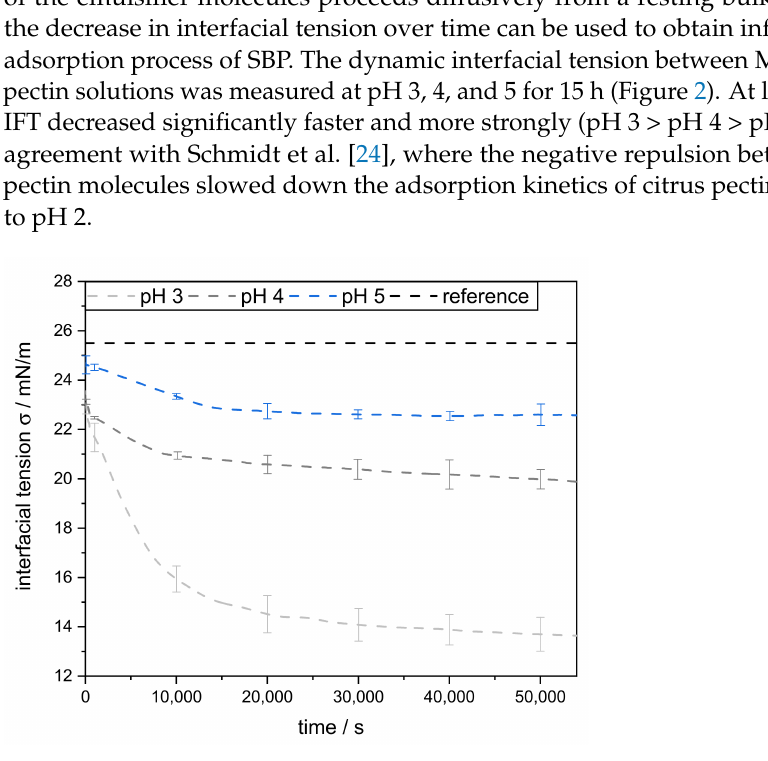
Figure 2. MCT oil-water interfacial tension, with 0.1 wt% sugar beet pectin in the aqueous phase, measured over the time at 25 ◦ C. As a reference, the IFT (interfacial tension) was measured without the addition of sugar beet